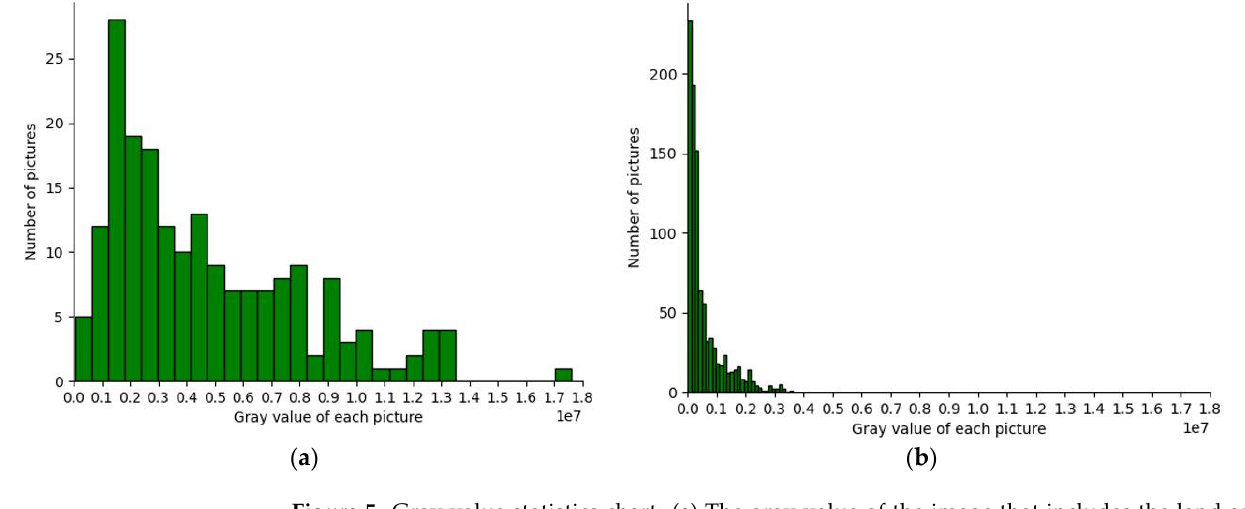
Figure 5. Gray value statistics chart: ( a ) The gray value of the image that includes the land area; ( b ) The gray value of the image that does not include the land area.